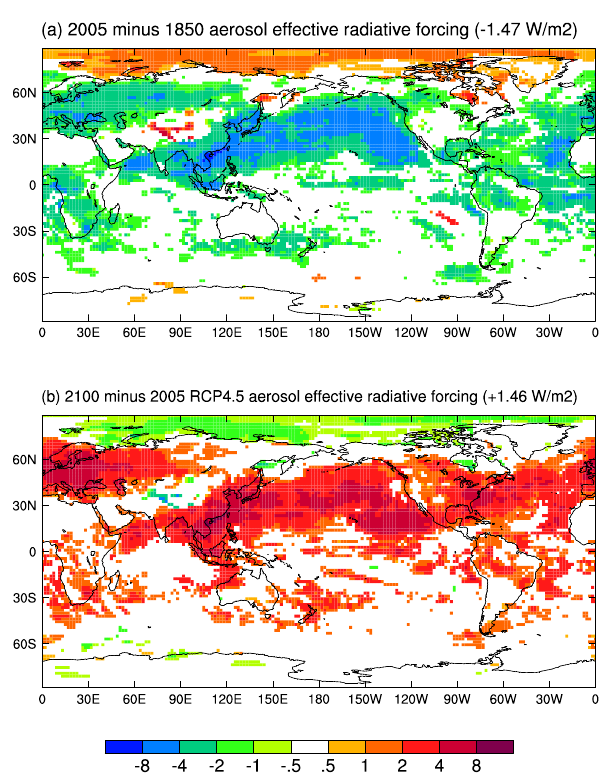
Fig. 4. Aerosol effective radiative forcing at the top of the at- mosphere (Wm − 2 ): (a) 2005 minus 1850, (b) 2100 minus 2005. Shaded regions show ERF values that are significantly different from zero at 5%, based on a two-sample t test. Fig. 5. Radiative forcing at the TOA, in the atmosphere, and at the